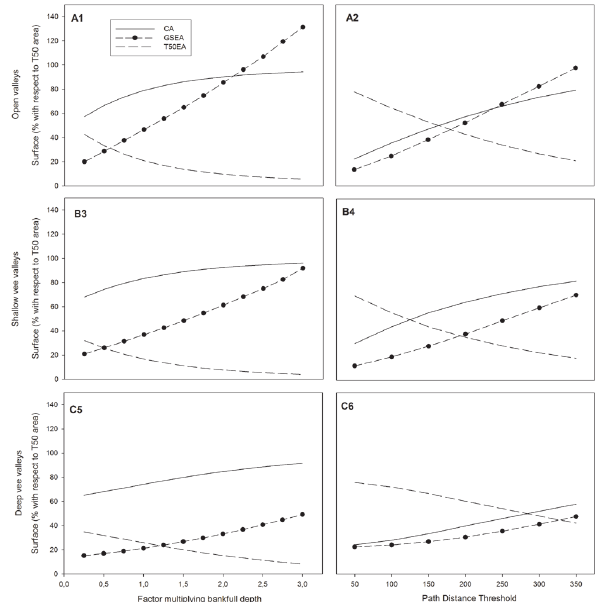
Fig. 7. Adjustment parameters when using a 10-m DEM: coinciding area (CA), 50-yr flood exceeding area (T50EA) and geomorpholog- ical surface exceeding area (GSEA) for bankfull depth ( 1 , 3 and 5 ) and path distance ( 2 , 4 and 6 ) approaches in open valleys ( A ), shal- low vee valleys ( B ) and deep vee valleys ( C ).